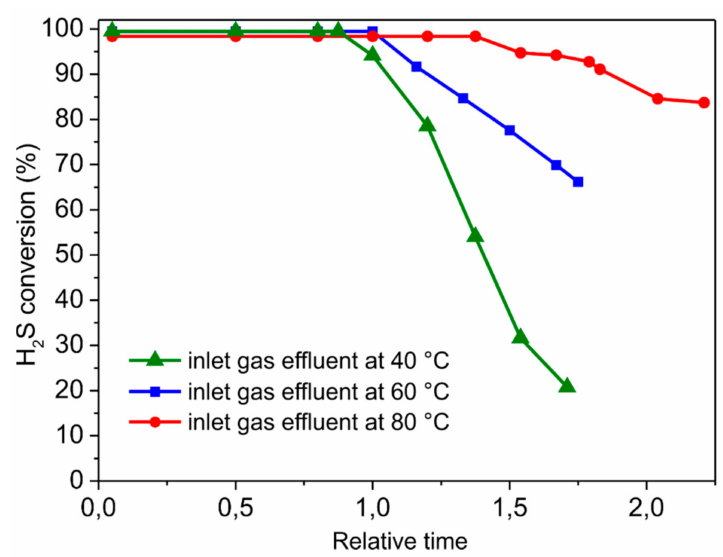
Figure 8. Influence of the reaction temperature on H 2 S conversion as a function of the relative breakthrough time with NiS 2 /SiC foam catalyst. The breakthrough time for NiS 2 /SiC foam at 60 ◦ C is conventionally assumed equal to 1. Reaction conditions: [H 2 S] = 1 vol.%, [O 2 ] = 2.5 vol.%, O 2 -to-H 2 S ratio = 2.5, [H 2 O] = 30 vol.%, balance helium, reaction temperature = 40, 60 and 80 ◦ C, GHSV (STP) = 1200 h − 1